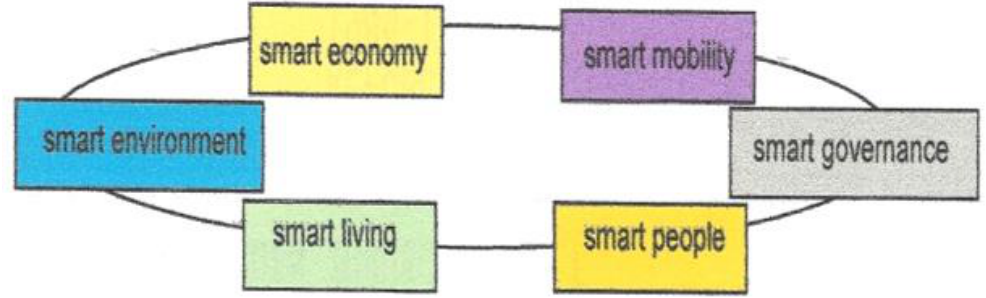
Figure 8. The 6 smart combinations of citizens' endowments and